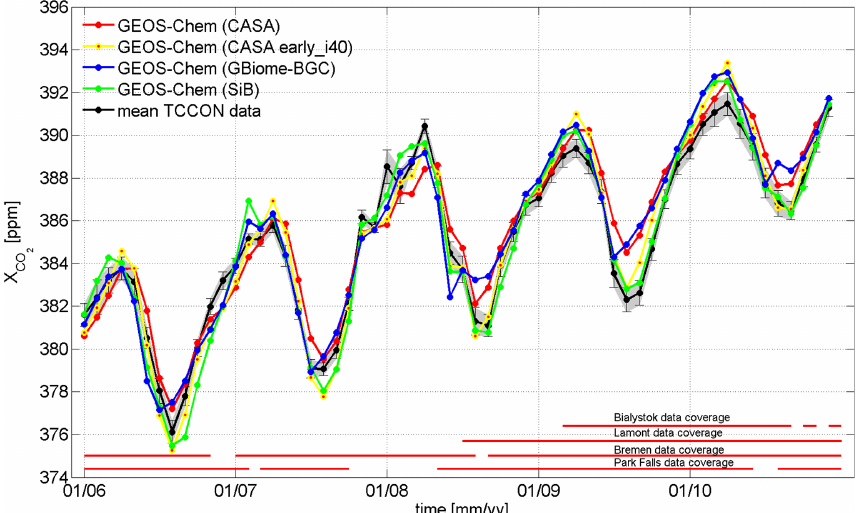
Fig. 2. The time series of the monthly averages of column averaged X CO . The black line shows the mean for the TCCON measurements 2 in Białystok (Poland), Bremen (Germany), Lamont (Oklahoma) and Park Falls (Wisconsin). The colored lines show the smoothed column averaged CO 2 for the three models (CASA, SiB, GBiome-BGC) and the manipulated CASA model (Sect. 7.2). The trend in the simulations is determined by the sum of the sources and sinks listed in Table 1. For the comparison the daily averaged GEOS-Chem CO 2 simulation profile for the same day was smoothed with the averaging kernel and a priori profile from the TCCON measurement and integrated to column averaged X CO . In comparison with the TCCON measurements, the GEOS-Chem CO 2 simulation with the SiB NEE input most 2 closely simulates the seasonal cycle and the manipulated CASA model improves significantly the comparison. The variability of the TCCON time series in the winter of 2007–2008 is due to the few measurements averaged (Table S1 in the